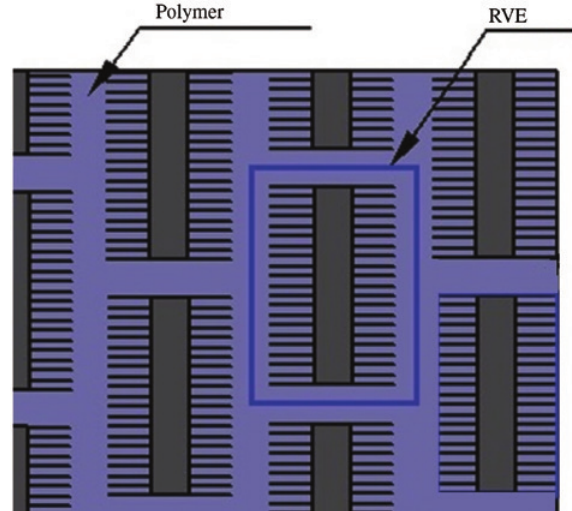
Figure 1: Fiber grown with